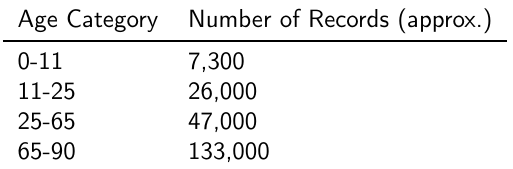
Table 3: Number of service agreement records with respect to the four age